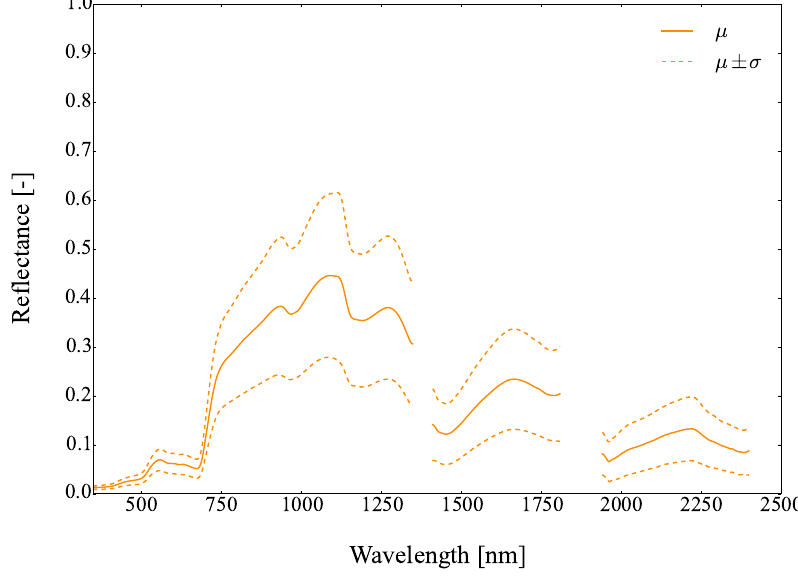
Figure A10. Mean reflectance ( µ ) and standard deviation ( σ ) of Menyanthes trifoliata